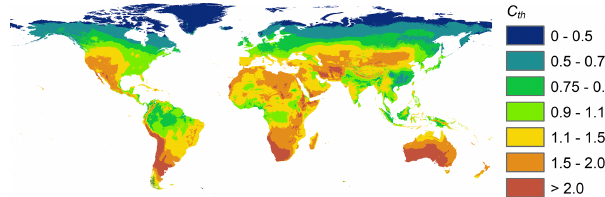
Figure 3. Global map of the annual partially weighted average C th